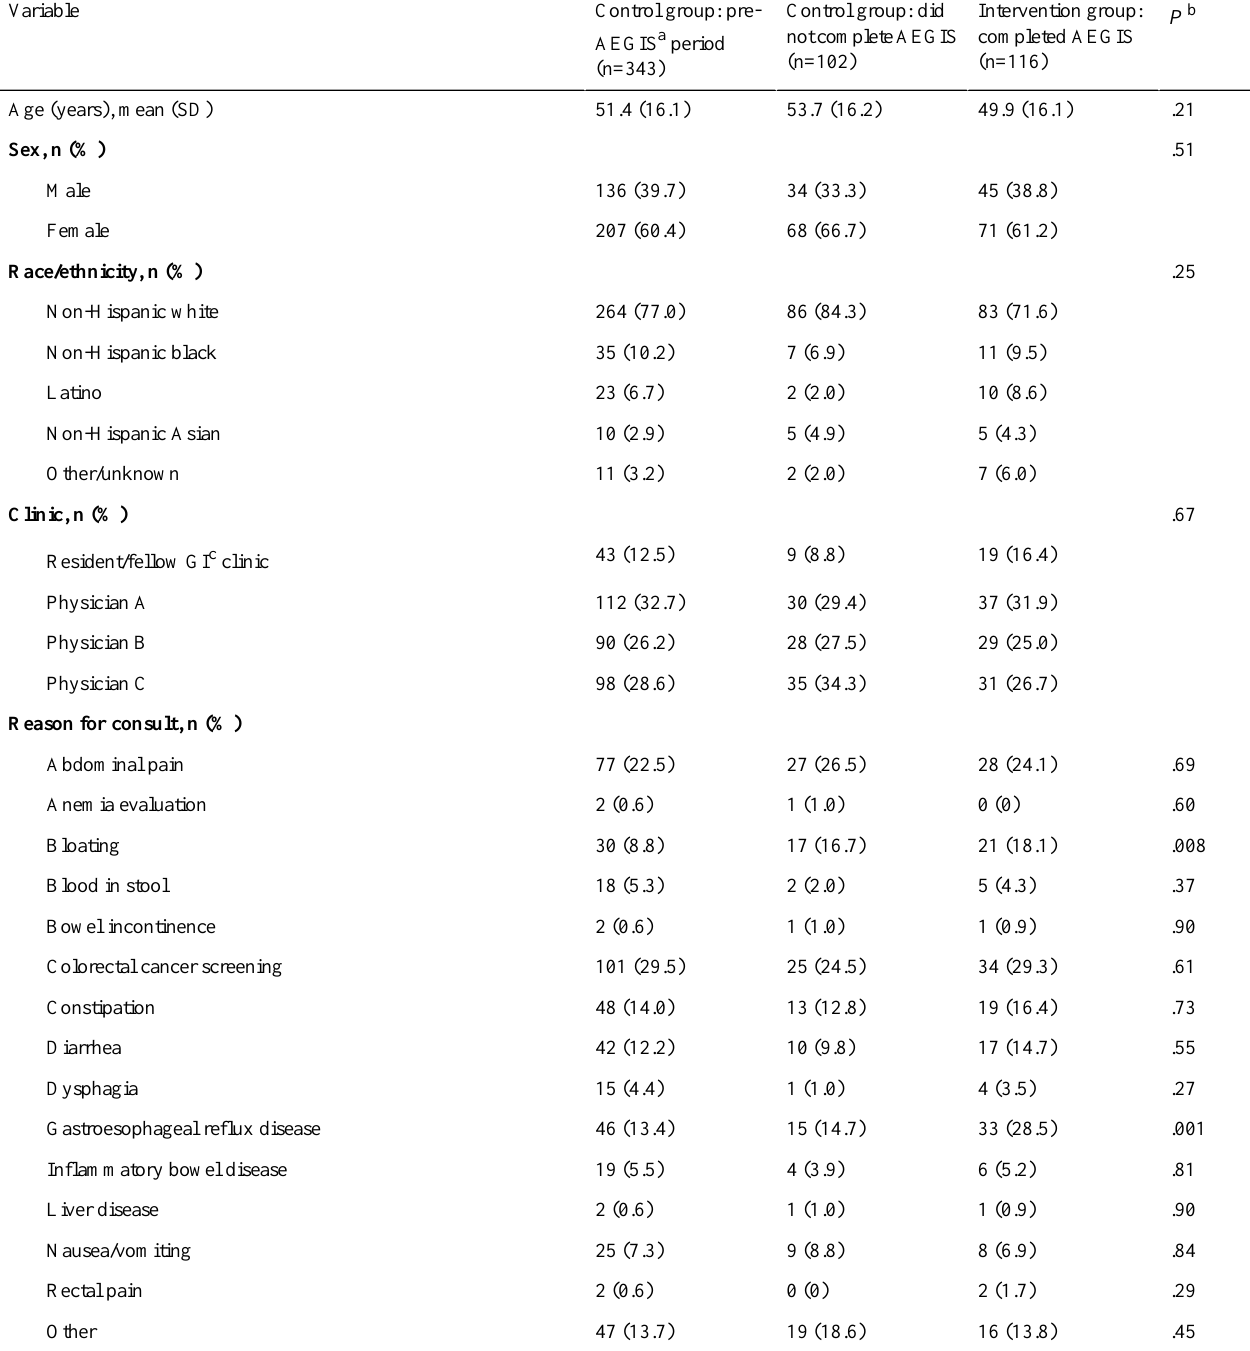
Table 2. Demographics of those in the matched cohort analysis